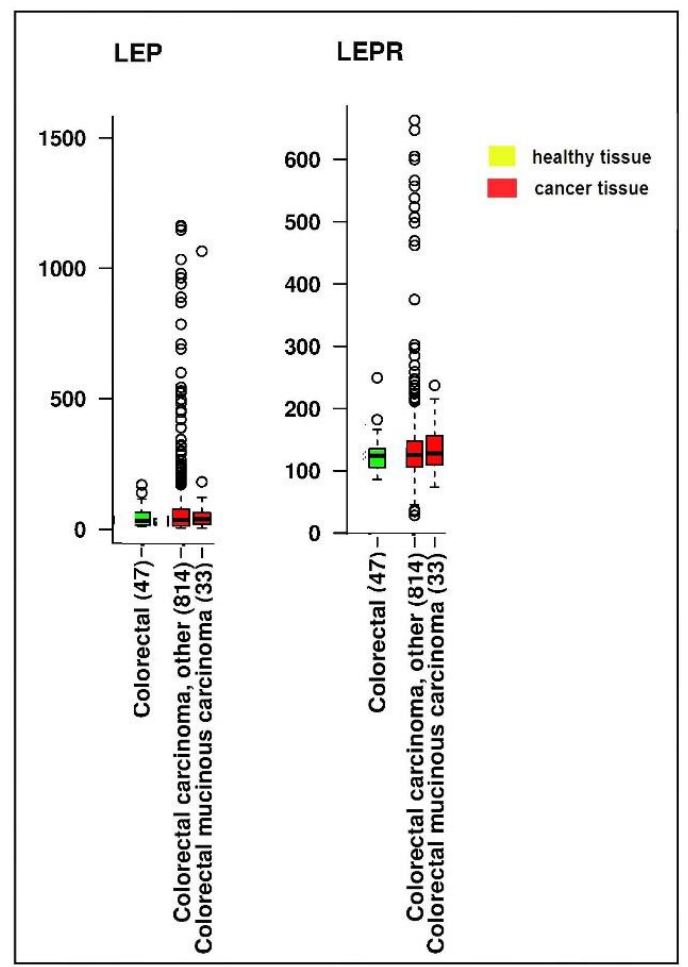
Figure 3. LEP and LEPR gene expression levels in healthy and in various colorectal carcinoma tissues. Data were retrieved from the online IST database (https://ist.medisapiens.com/, accessed on 24 June 2021).